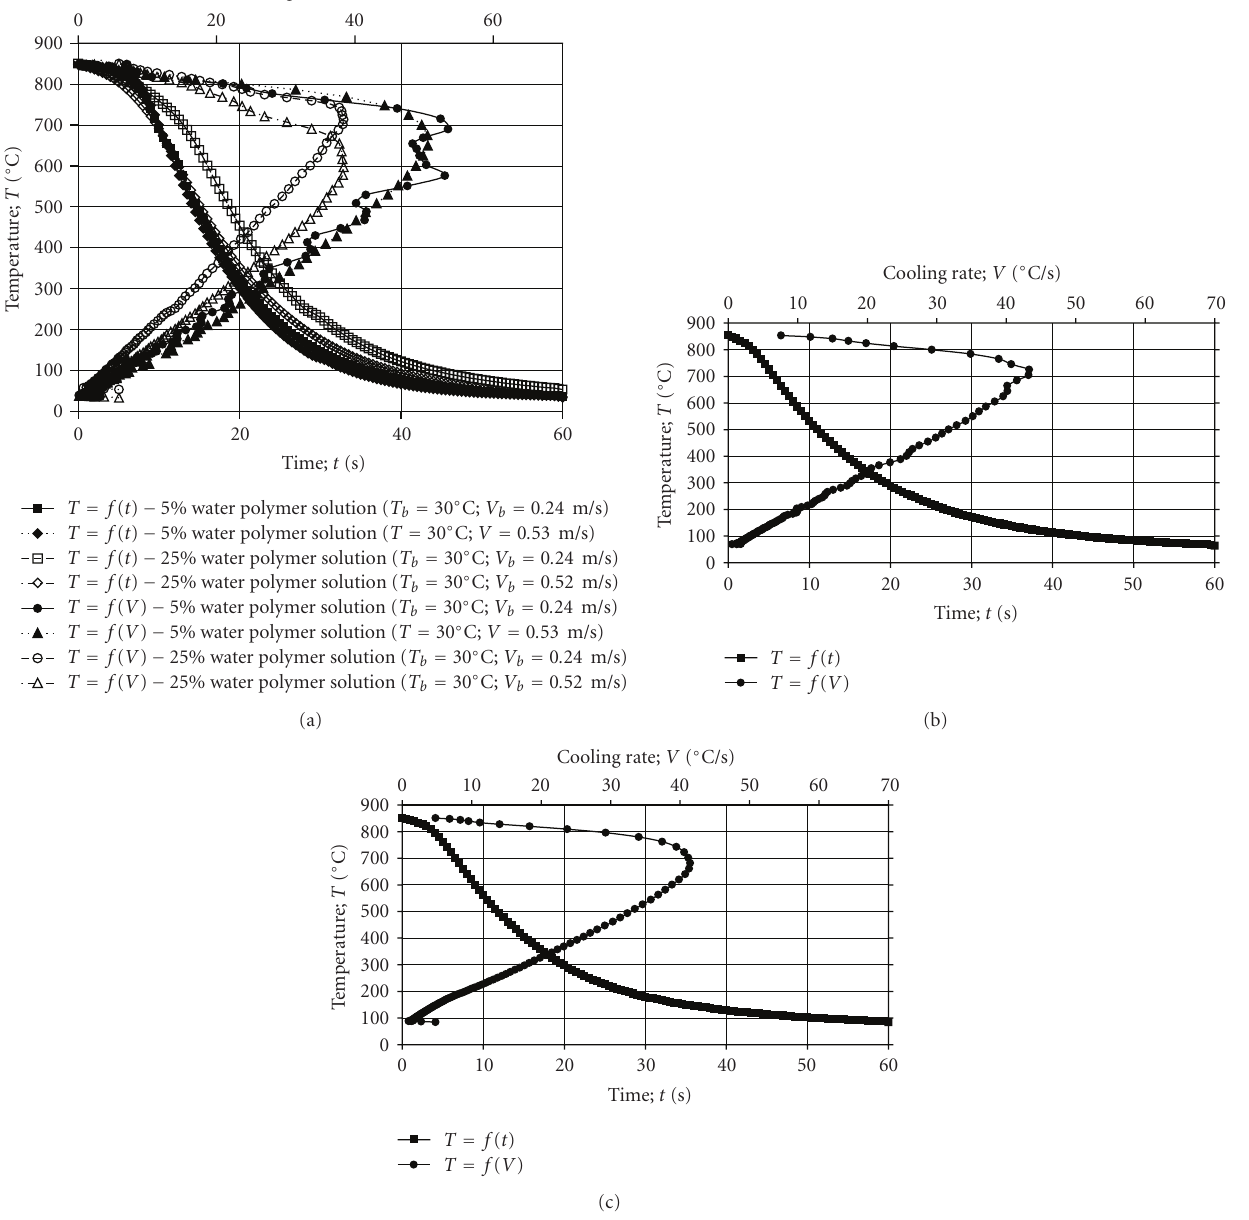
Figure 3: Cooling time and rate curves for (a) 5%–25% water polymer solution; (b) OH70 oil; (c) Mar-Temp 890 oil. (Quenching temperature and agitation rate were shown in Table 2 and the figure